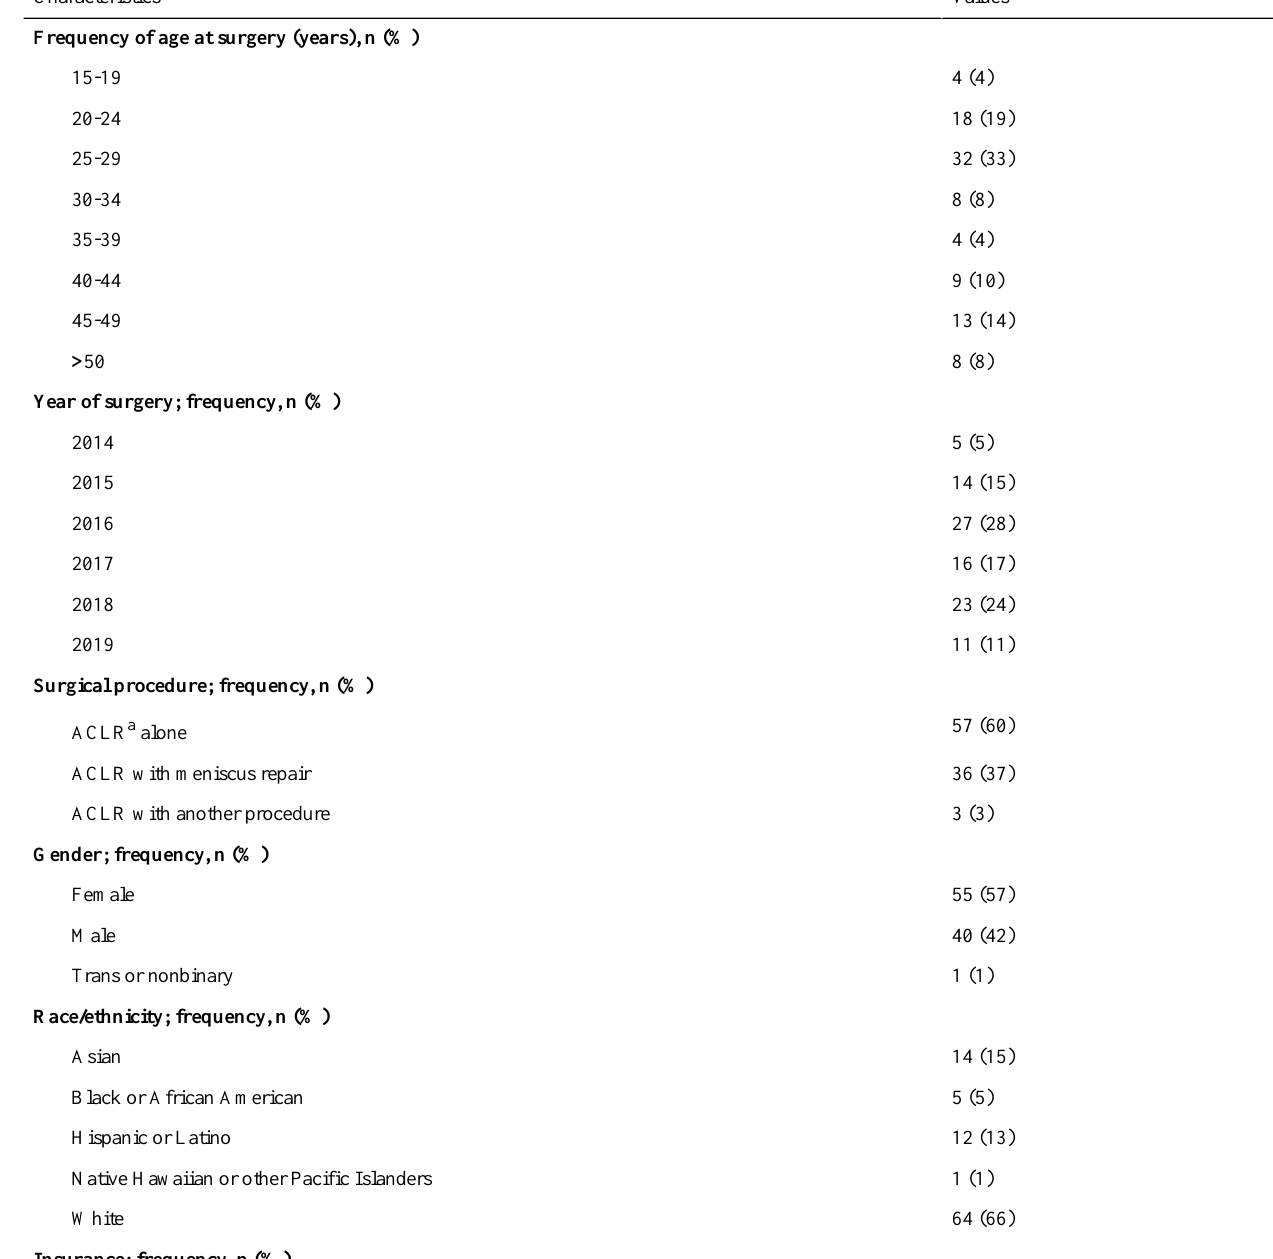
Table 1. Demographics and patient characteristics (N=96).